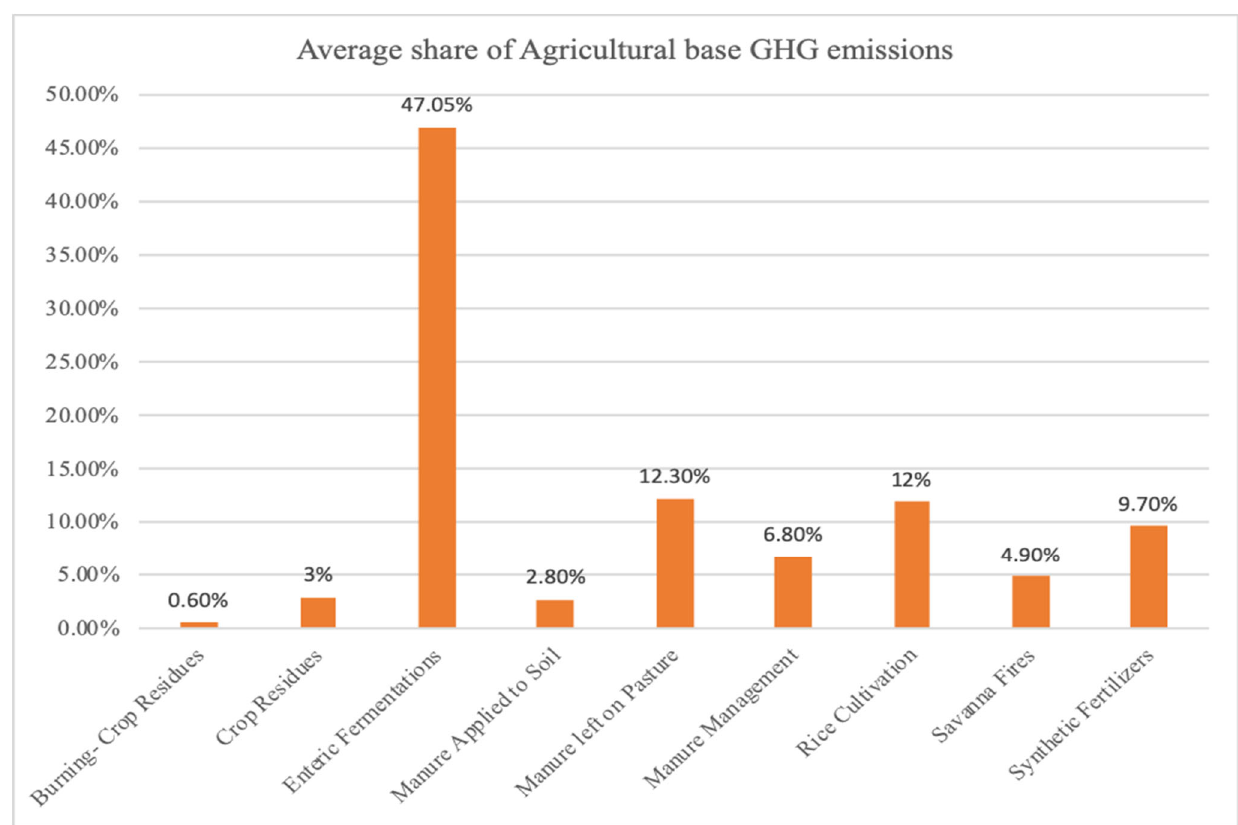
Figure 1. Global average share of Agro ‐ Base GHG emissions 2000–2019 [13].